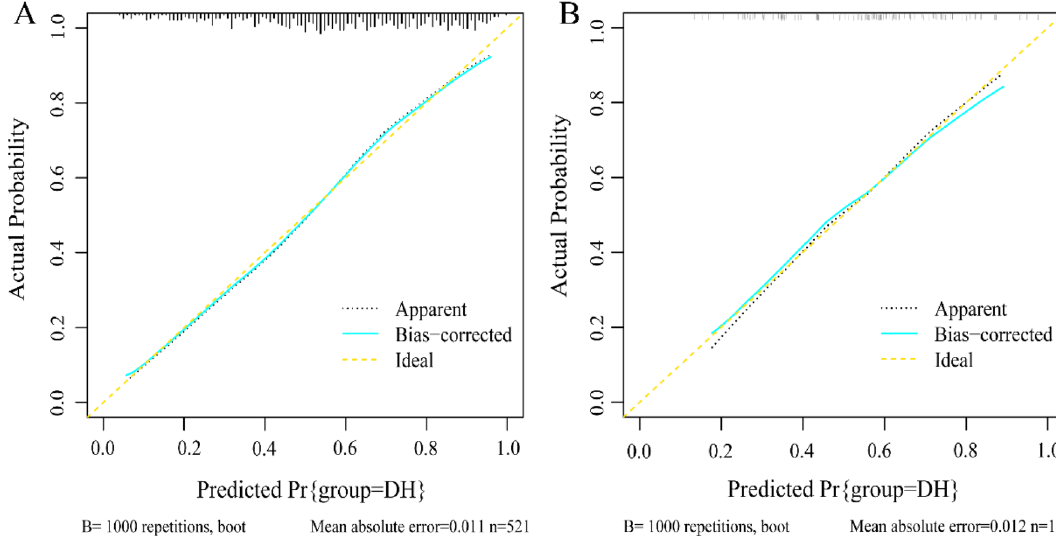
Figure 5. Calibration curves of the nomogram. ( A ) represents the calibration curve of the training set, and ( B ) represents the calibration curve of the validation set. The x-axis represents the predicted probability of DH. The y-axis represents the actual diagnosed DH. the yellow dashed line represents the perfect prediction with the same predicted probability as the actual probability. The black dashed line represents the performance of the nomogram and the green solid line represents the performance of the model after calibration. The closer the calibration curve of the model is to the yellow dashed line, the better the model prediction is represented.